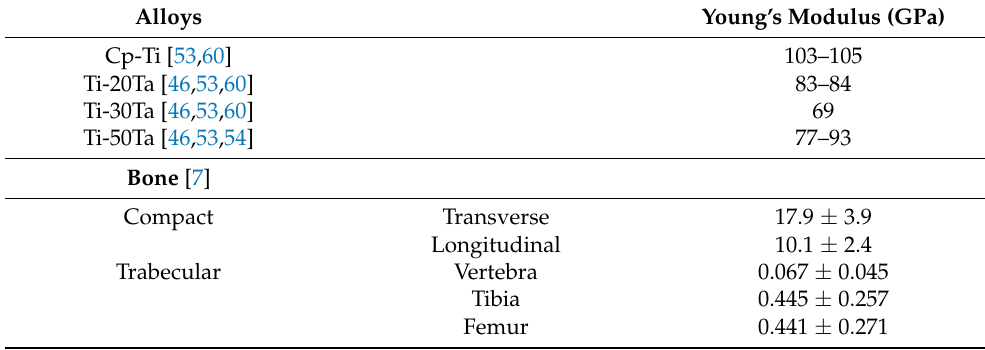
Table 3. Mechanical properties of Ti-Ta alloys and human bones reported in the